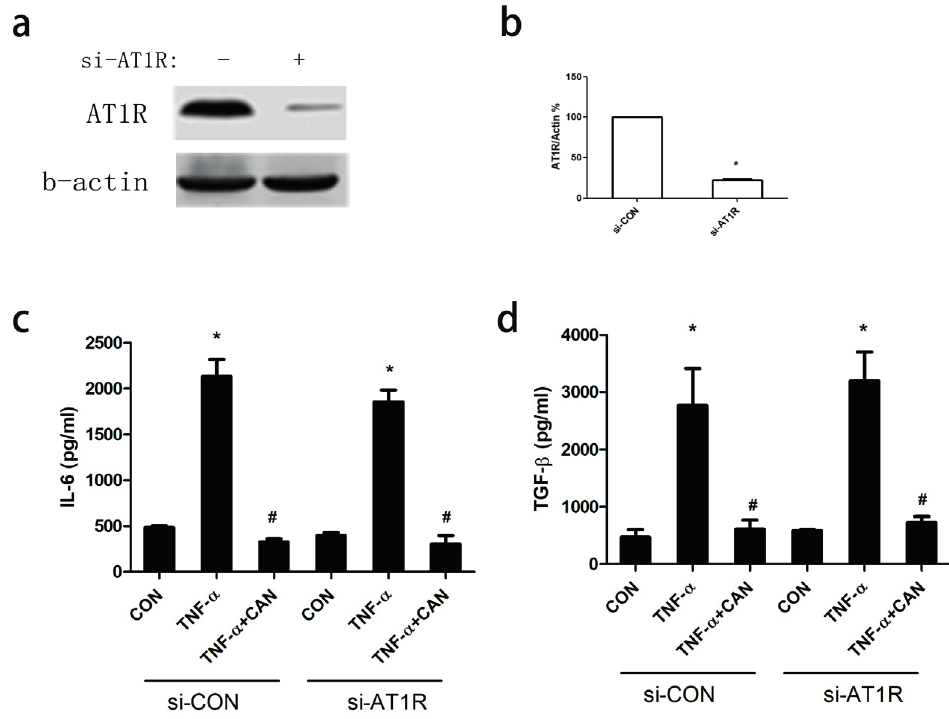
Figure 2 - Knockdown of AT1R did not affect candesartan suppression of TGF-β and IL-6 induced by TNF- α . HKC were transfected with AT1R siRNA or scrambled siRNA （ 100nM ） for 24 hours. Then cell lysates were immune-blotted with anti-AT1R antibody ( a , b ). After transfection, cells were treated with TNF- α (2ng/ml) along or TNF- α combination with candesartan (10 -5 M) for 24 hours. Conditional media from cultured cells were collected and TGF-β ( c ) or IL-6 ( d ) levels were determined by ELISA (n=3). *P<0.05 vs. CON, #P<0.05 vs. TNF- α treatment; CON: control, CAN: candesartan.